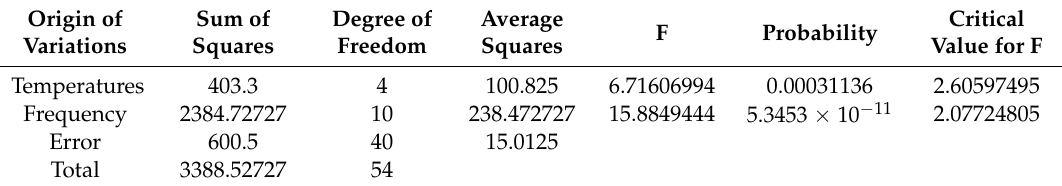
Table 7. ANOVA for